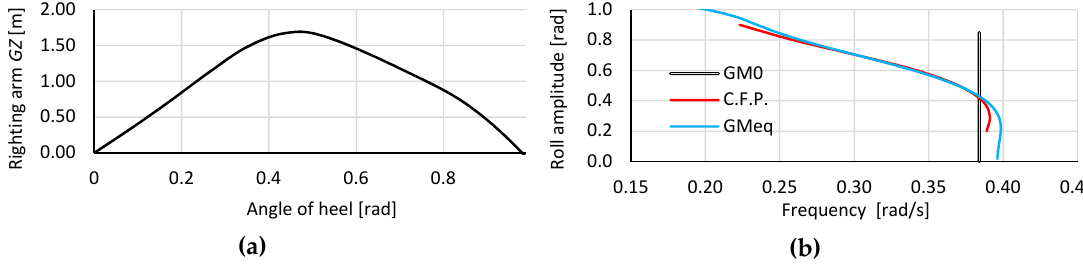
Figure 1. The GZ curve ( a ) and the resonance frequency curve ( b ) for the LNG carrier in ballast loading condition ( T = 7.50 m, GM 0 = 4.00 m).